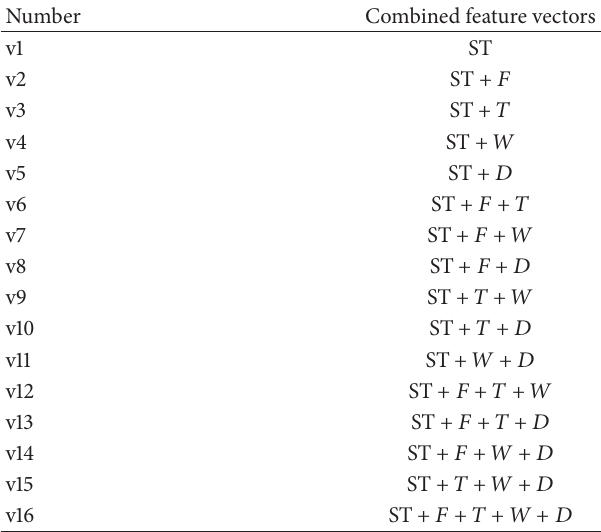
Table 3: The details of the different combined feature